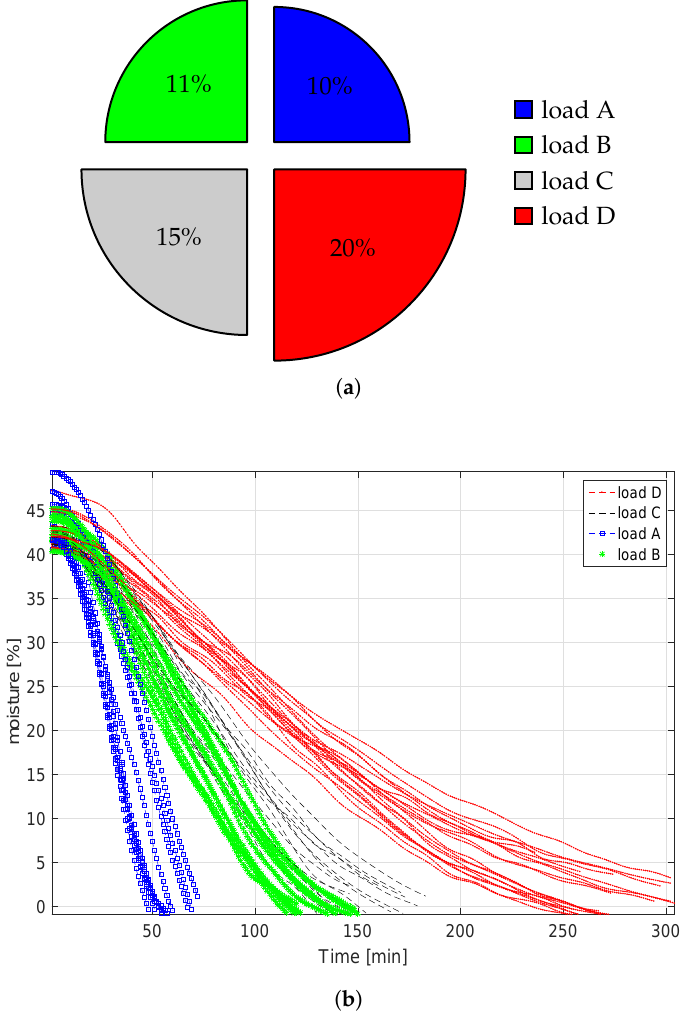
Figure 6. Data visualization by (dry) laundry load weight: ( a ) Laundry load weight distribution in the data, 4 classes in kg, and ( b ) laundry moisture